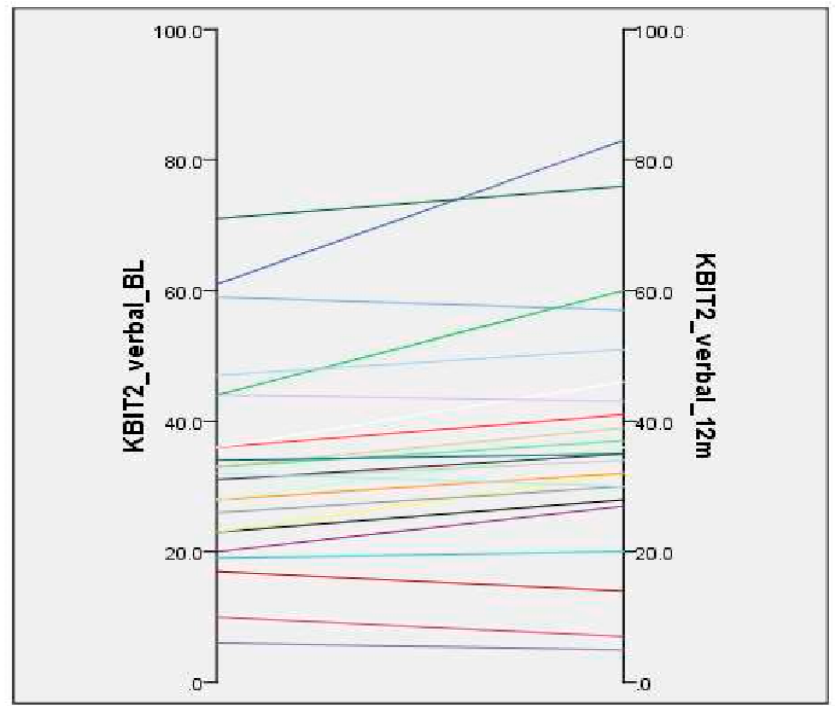
Figure A1. Change in K-Bit Verbal Scores over 12 months.